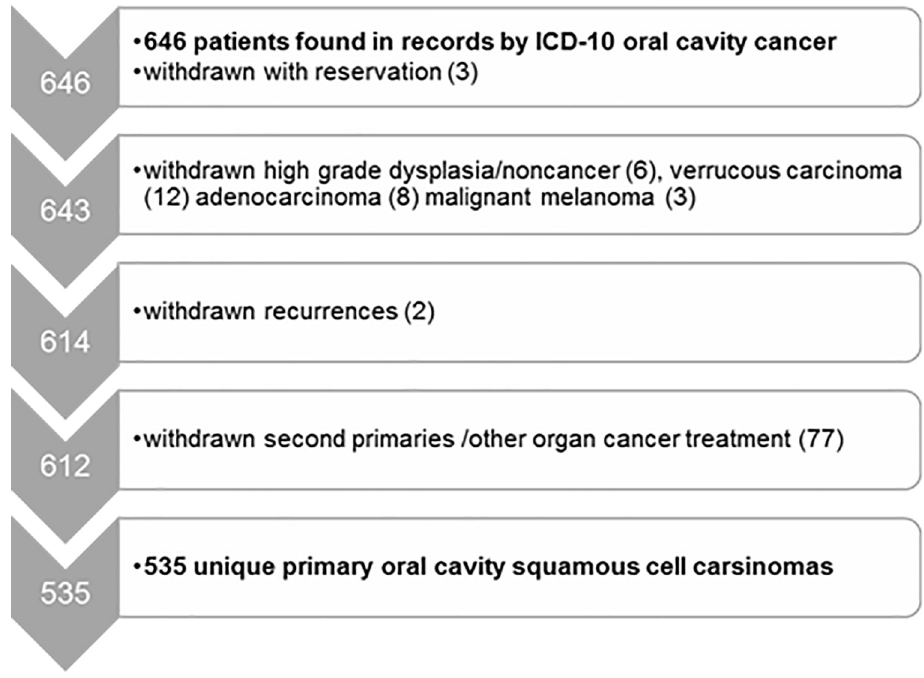
Fig 1. Flowchart outlining how we identified 535 unique primary treatment-na ï ve oral cavity squamous cell carsinomas in Norway in the time period 2005–2009.